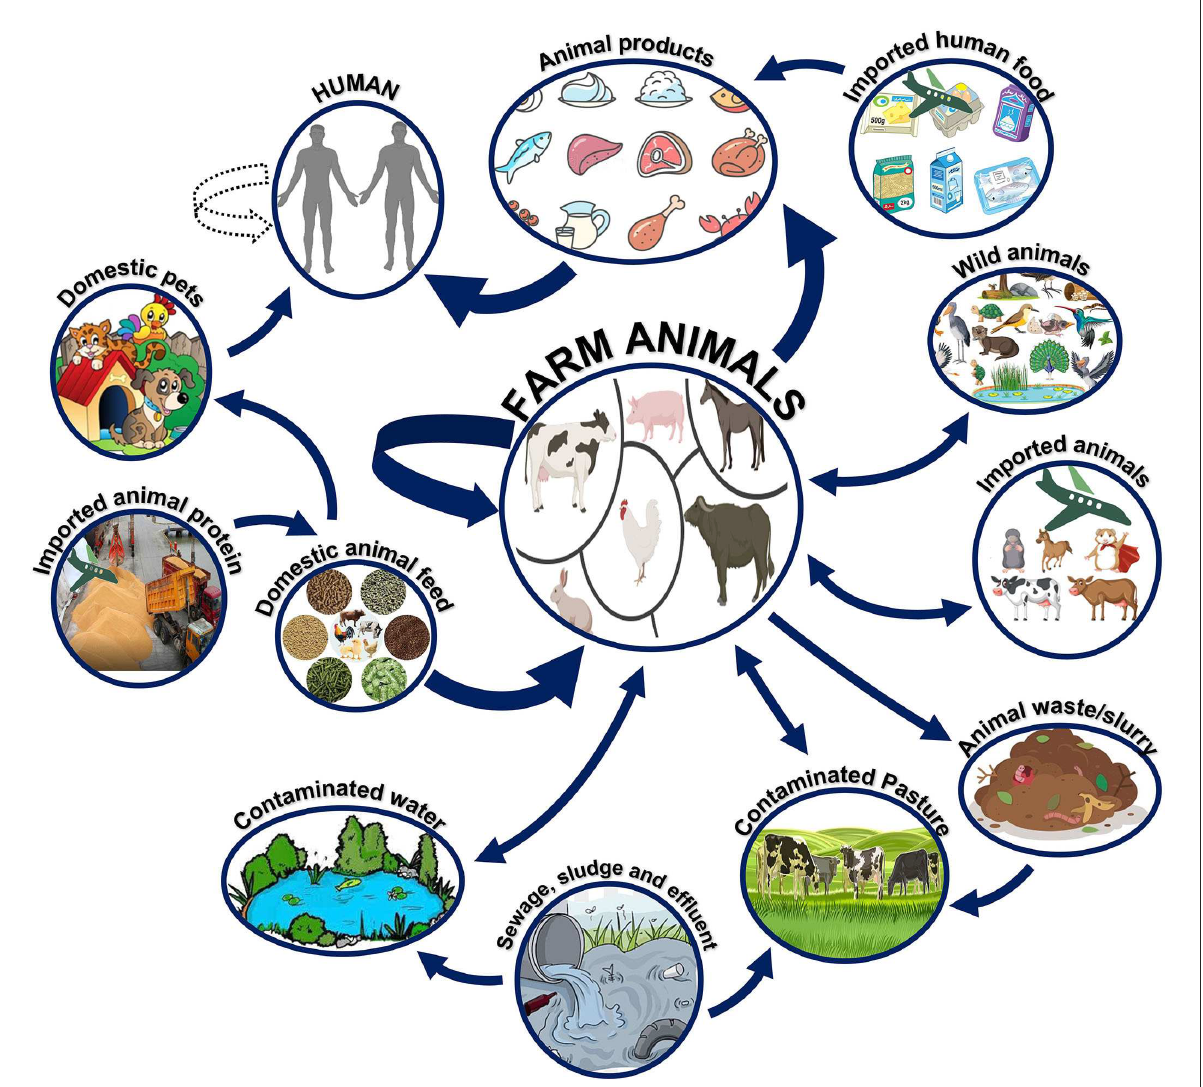
FIGURE6 Reservoirs and transmission of non-typhoidal Salmonella (NTS). Farm animals serve as the main reservoirs for non-typhoidal Salmonella . The pathogen can survive in various animals or environments and eventually be transmitted to humans via consuming contaminated meat products or via direct contact with domestic